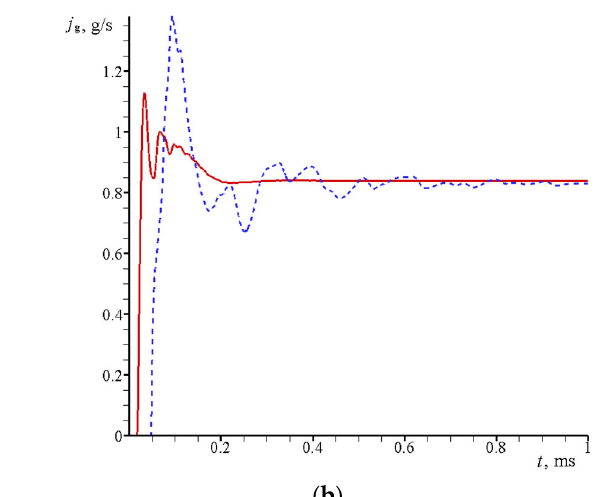
t following at time i